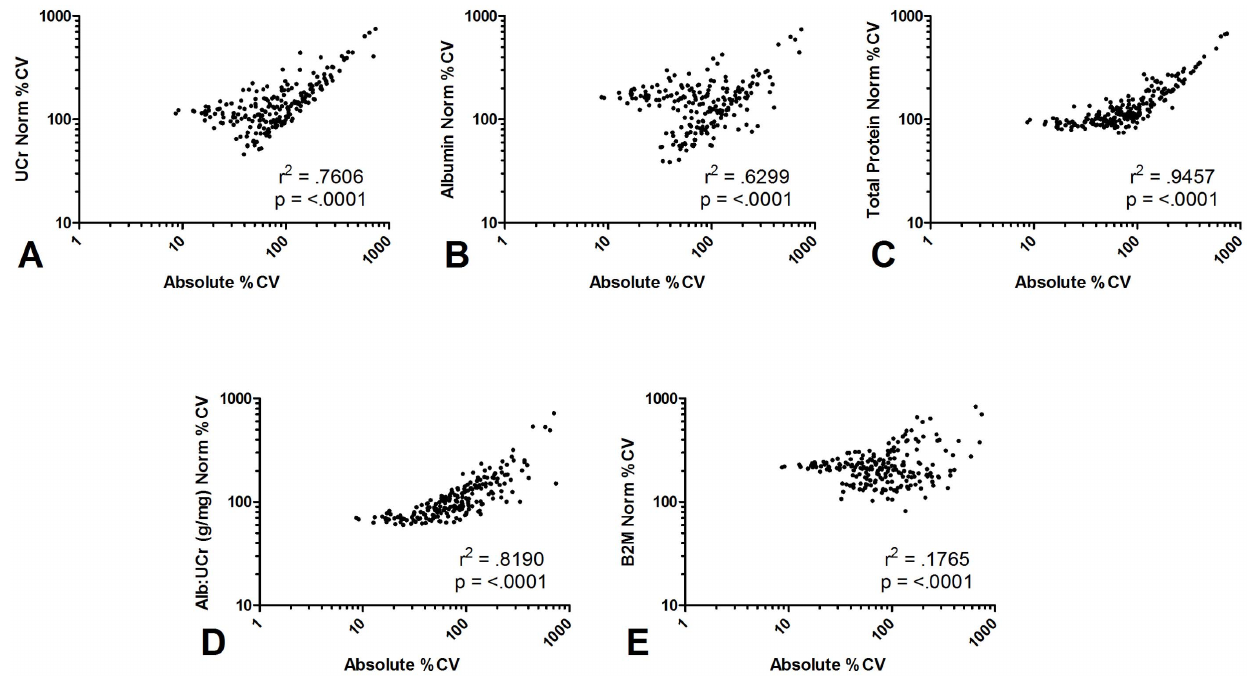
Figure 2. Effect of several normalization methods on the population variability of urine proteins. Urines obtained from 103 healthy donors were evaluated for levels of 211 proteins using multiplexed bead-based immunoassays. Coefficients of variation (CV) were determined for each of the 211 urine proteins based on absolute and normalized values. Correlation between the two sets of values was evaluated using Pearson’s test of correlation. Normalized values were calculated by dividing absolute biomarker concentration by the level of several urine parameters: A . urine creatinine (UCr); B . urine albumin; C . urine total protein; D . ratio of urine albumin to urine creatinin (ACR); E . b -2-microglobulin. immunoassay. A representative western blot for osteopontin (OPN), CA 125, HE4, and transthyretin (TTR) is presented in Figure 3. Monoclonal antibodies directed against osteopontin, HE4, and TTR detected a single protein isoforms of each. Osteopontin migrated with an apparent molecular mass of 60 kDa, while HE4 and TTR migrated at 13 and 15 kDa, respectively. A monoclonal antibody directed against CA 125 detected three distinct protein fragments. The major CA125 fragment migrated in SDS-PAGE with an apparent molecular mass of 41 kDa (shown) and two smaller protein bands were in the range of , 28–30 kDa. The presence of each CA 125 protein fragments detected in human urine was confirmed using several additional anti-CA 125 antibodies (data not shown). A highly abundant 68kDa fragment corresponding to THP was visualized in each sample.